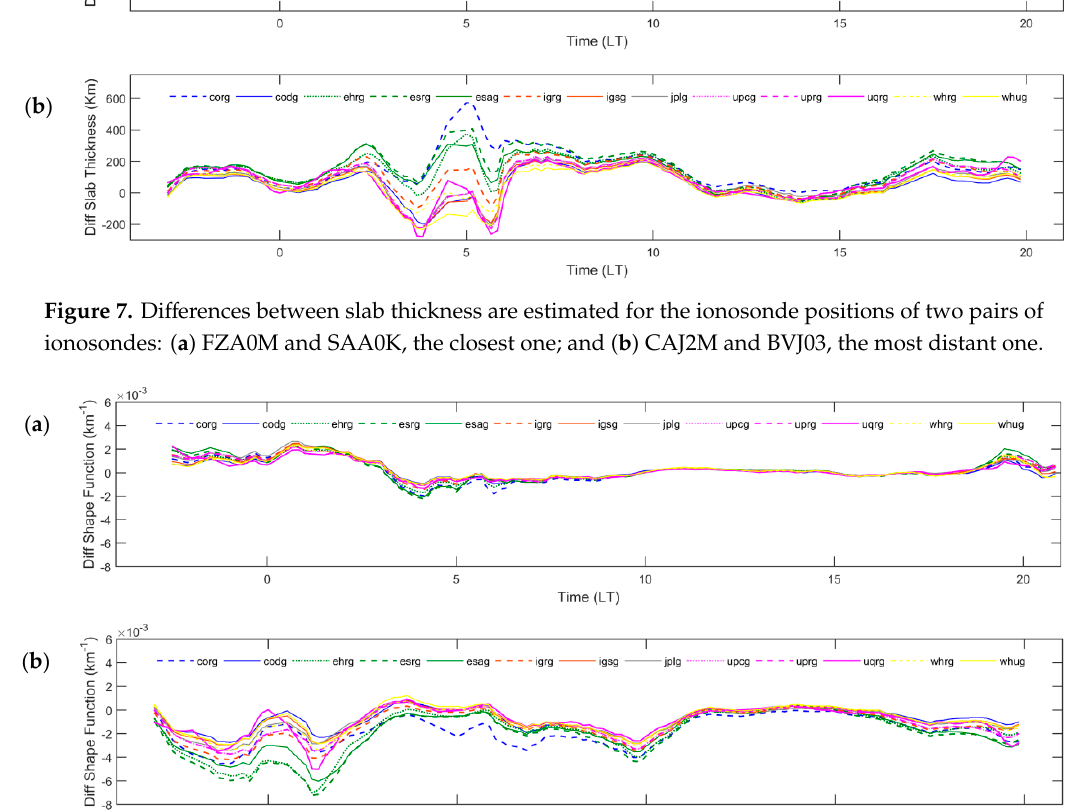
Figure 8. Differences between shape function peak estimated for the ionosonde positions of two pairs of ionosondes: ( a ) FZA0M and SAA0K, the closest one; ( b ) CAJ2M and BVJ03, the most distant one.